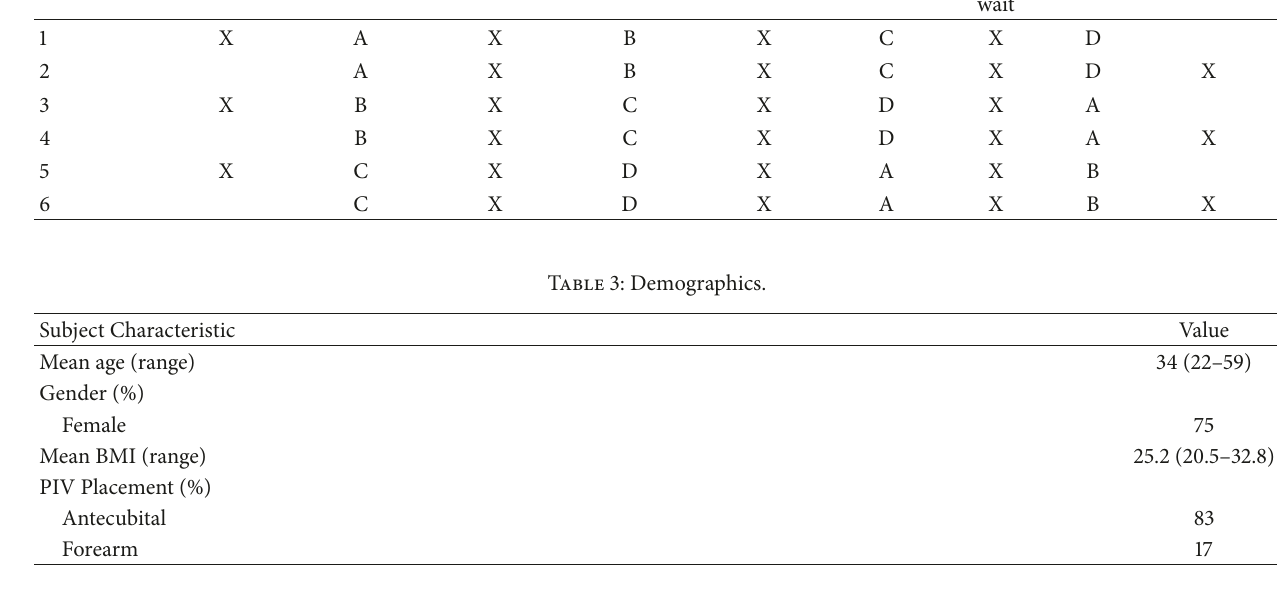
Table 4: Differences of least squares means,